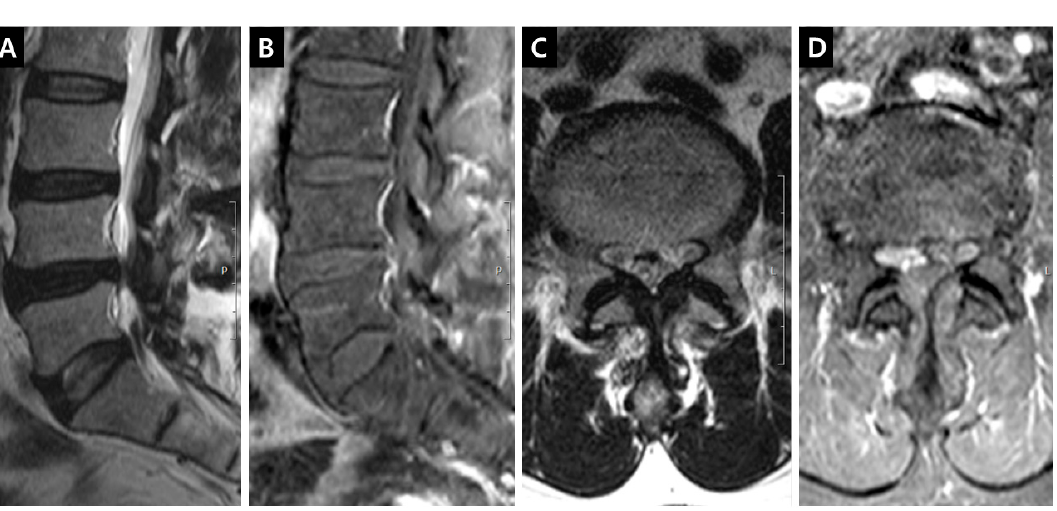
Figure 2. Enhancement patterns: periradicular vein (PVCE). ( A ) T2-weighted right parasagittal image showing the origin of right L5 traversing root; ( B ) Fat-suppressed enhanced T1-weighted right parasagittal image indicating the periannular enhancement on the right subarticular L4-5 annulus; ( C ) T2-weighted axial image on the L5 upper endplate level; ( D ) Fat-suppressed enhanced T1-weighted axial image on the L5 upper endplate level, the definite periradicular enhancement around the right L5 traversing root can be seen in the lateral recess.